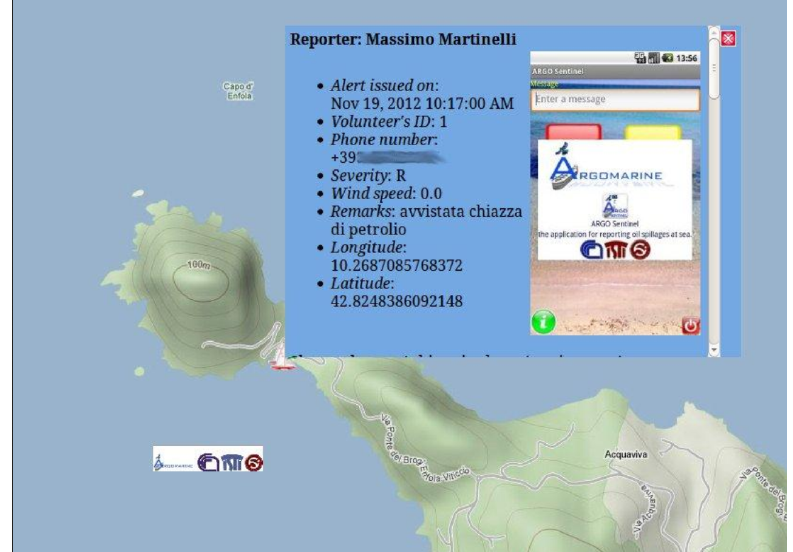
Figure 4. A report displayed through the Marine Information System (MIS) web interface of an alert produced by a volunteer: data, identifier of the volunteer (if registered), severity, wind speed, remarks, latitude and longitude are